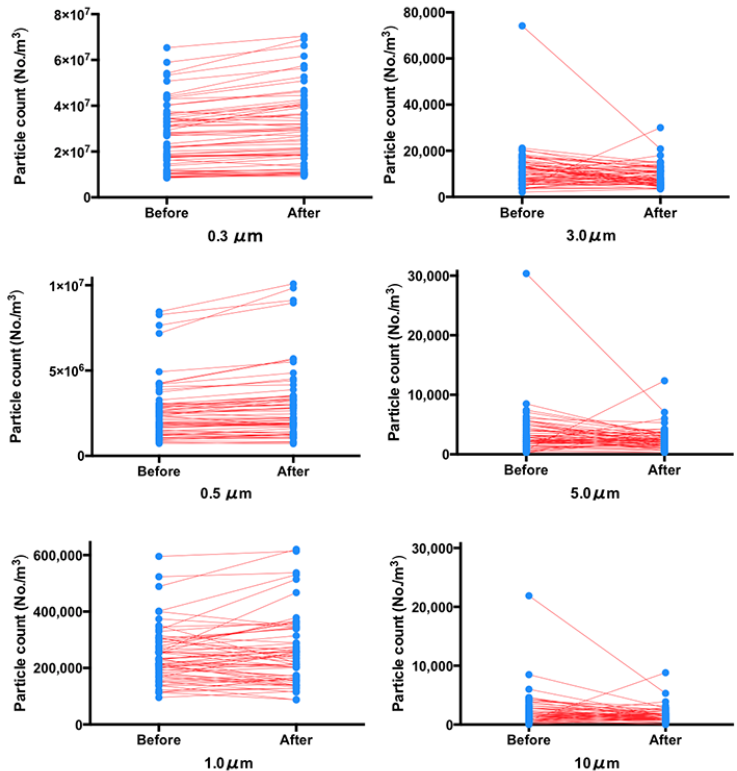
Figure 2. Changes in the six particles before and after the esophagogastroduodenoscopy examination using the extraoral suction device (n = 61).